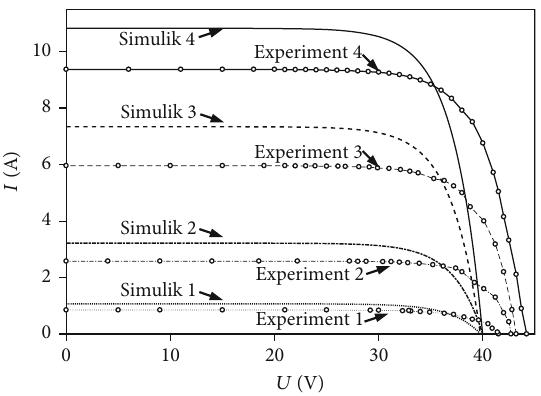
Figure 3: Mathematical model and experimental